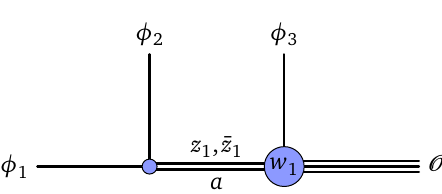
Figure 6 : One of the four-point functions obtained in the OPE limit for the middle leg in a six-point function in comb channel. The rightmost field is a Mixed-Symmetry Tensor with two spin indices and the exchanged field is a Symmetric Traceless